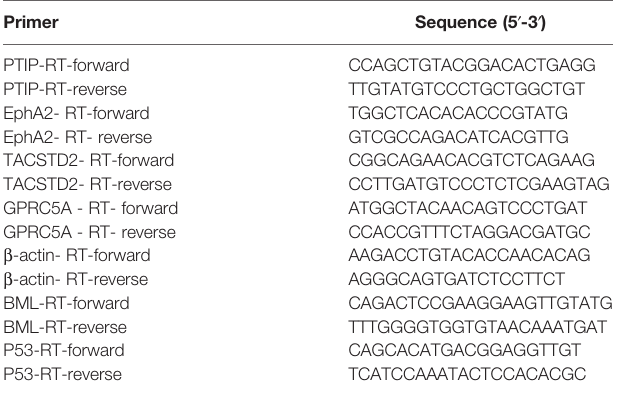
TABLE 2 | Primers used for Real-time